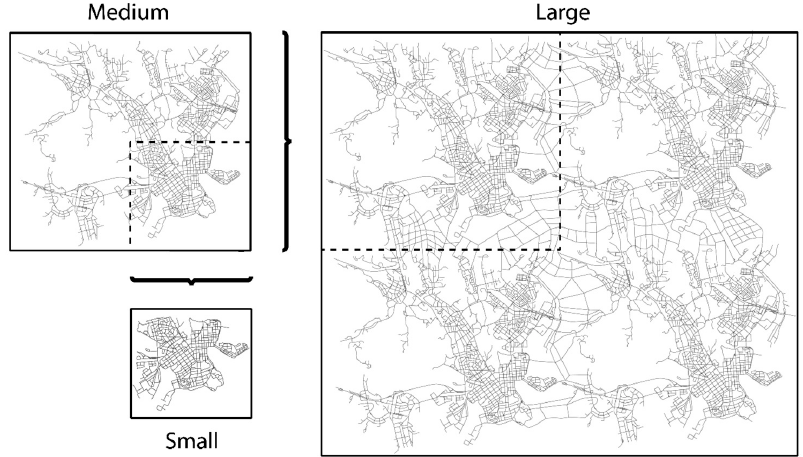
Figure 3. Movement scenarios used for investigating the impact of increasing node population and spatial locality on the performance of OppNet replication techniques (partitioned by a grid, the small, medium and large scenario consists of 1 region, 4 regions and 16 regions, which also corresponds to low, medium and high degree of spatial locality, respectively).